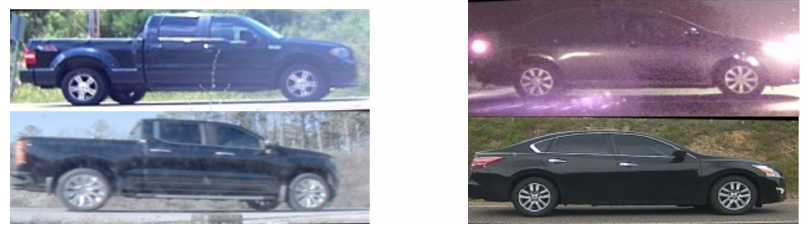
Figure 1. Similar looking vehicles with different